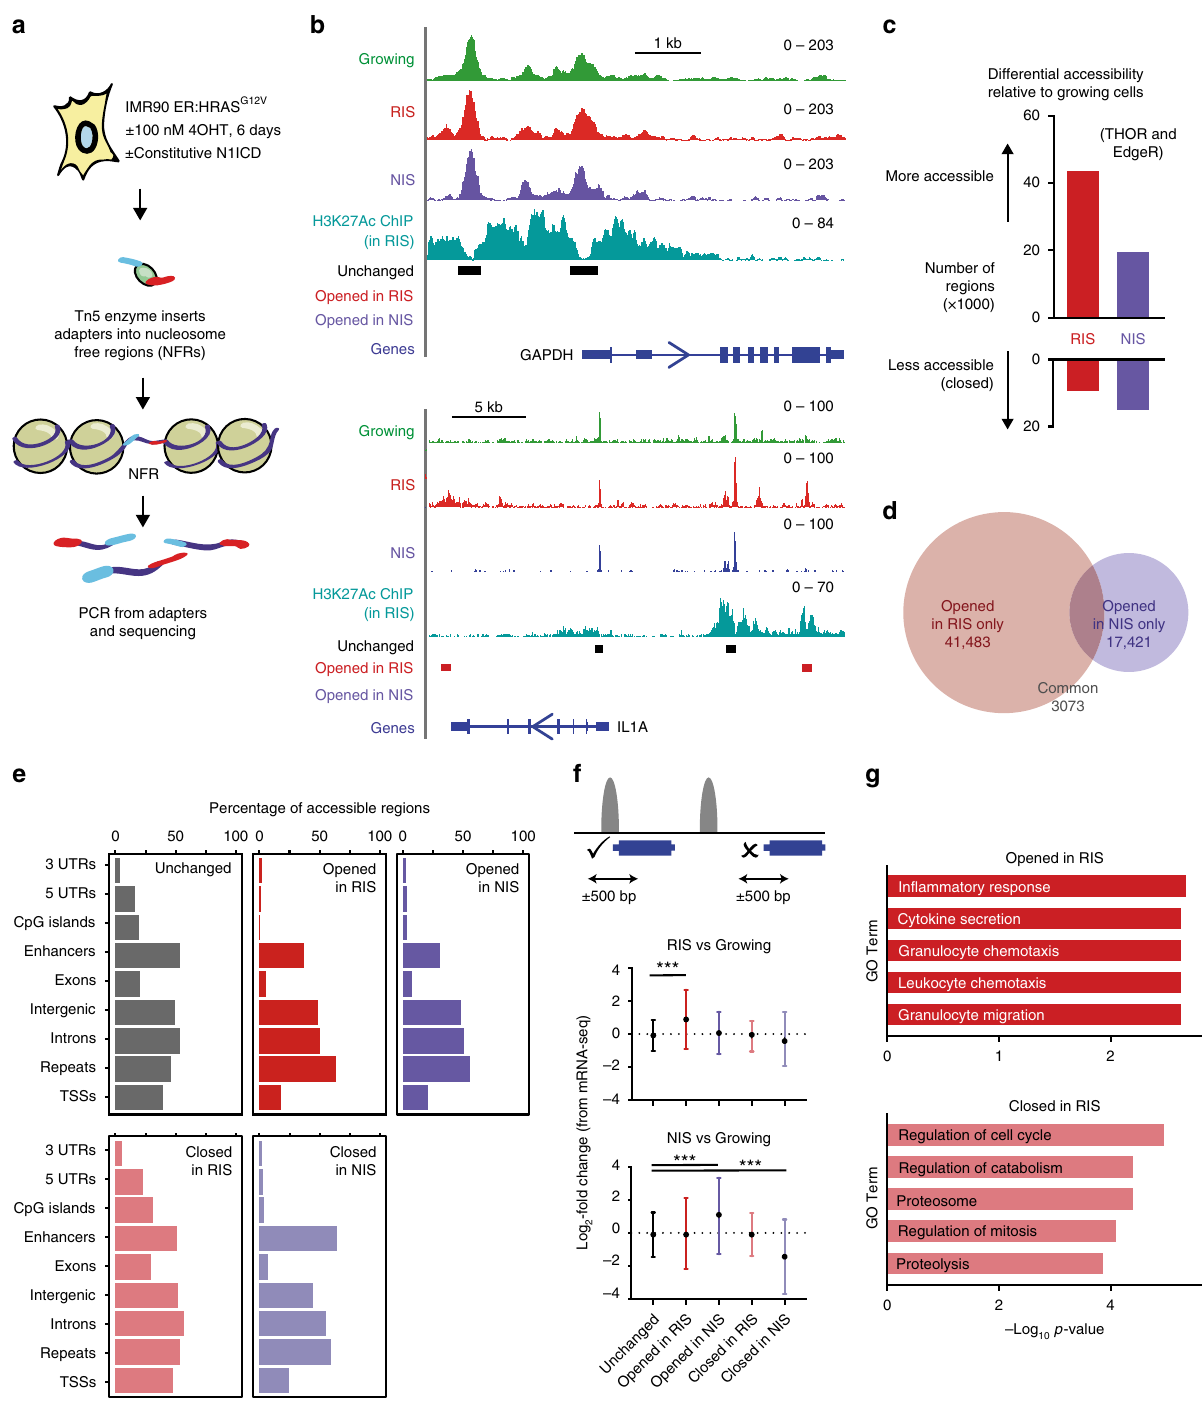
Fig. 4 Chromatin accessibility re fl ects gene transcription in RIS and NIS cells. a Diagram illustrating the method of ATAC-seq. b Genome browser images showing normalised ATAC-seq coverage and an active enhancer-associated histone modi fi cation (H3K27ac) in the cell conditions indicated around the GAPDH and IL1A genes. Unchanged = accessibility unaltered in RIS or NIS cells relative to growing; Opened in RIS = more accessible in RIS vs. growing cells; Opened in NIS = more accessible in NIS vs. growing cells (by edgeR and THOR). c Number of regions that become more accessible and less accessible in RIS and NIS cells relative to growing cells (intersect of edgeR and THOR). d Number of regions that are more accessible in RIS that are overlapping with a region that is more accessible in NIS (vs. growing). e Annotation of more (opened) and less (closed) accessible regions in RIS and NIS cells to genomic regions. f Accessible regions within the indicated subsets were annotated to genes if within 500 bp of a TSS. The average log 2 -fold expression change (by mRNA-seq) of genes in RIS or NIS cells relative to growing cells is plotted. Values are mean ± s.d. Statistical signi fi cance calculated using a one-way ANOVA with Tukey ’ s correction for multiple comparisons. *** p ≤ 0.001. g Gene ontology analysis (GO Biological Process 2015) using the TSS proximal accessible regions described in